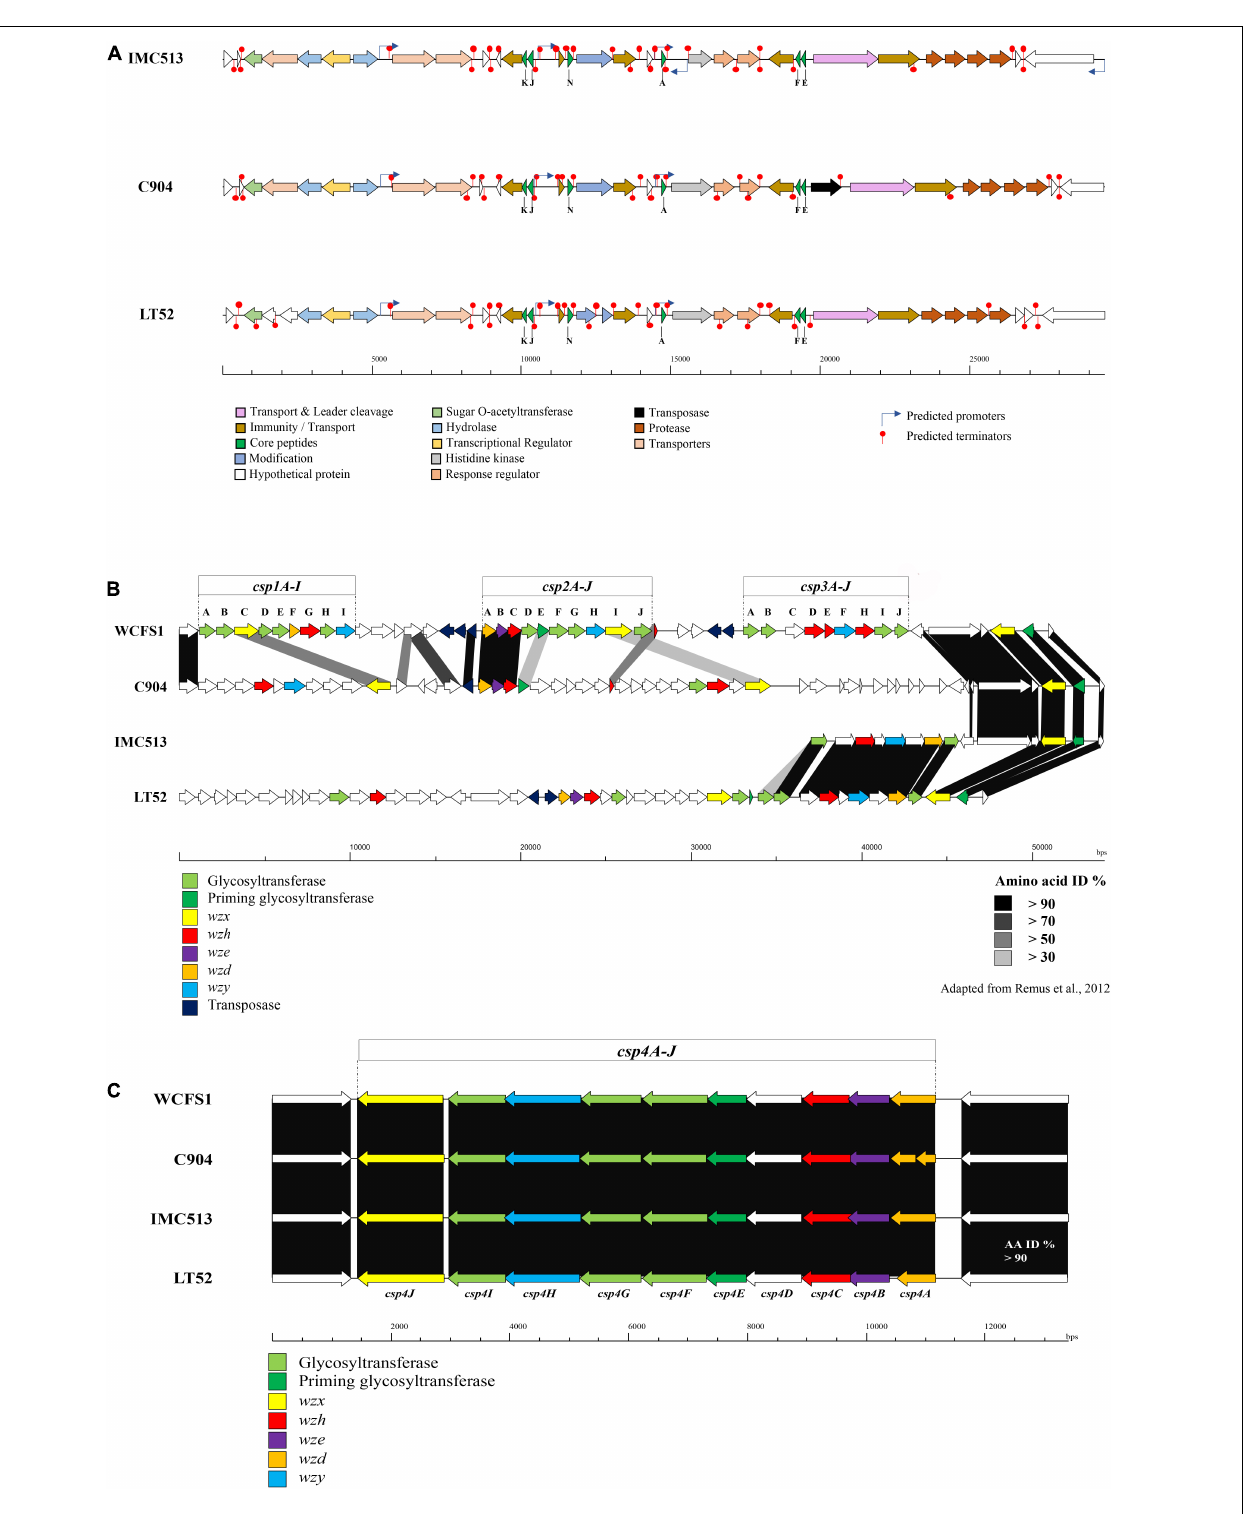
FIGURE 5 | (A) Overview of plantaricin operons in the three Lpb. plantarum evaluated. Gene maps show complete plantaricin regions with arrows representing ORF colored according to the predicted function. Bagel3 predicted promotors and terminators are also indicated. (B) Genetic organization of the putative polysaccharide biosynthesis gene clusters ( cps ) of the three Lpb. plantarum strains evaluated. (C) Map of the Lpb. plantarum WCFS1 cps gene clusters 1, 2, and 3 and comparison with the Lpb. plantarum strains C9O4, IMC513, and LT52.